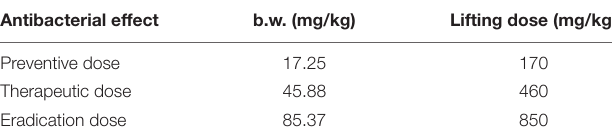
TABLE 5 | Dosage for different drug